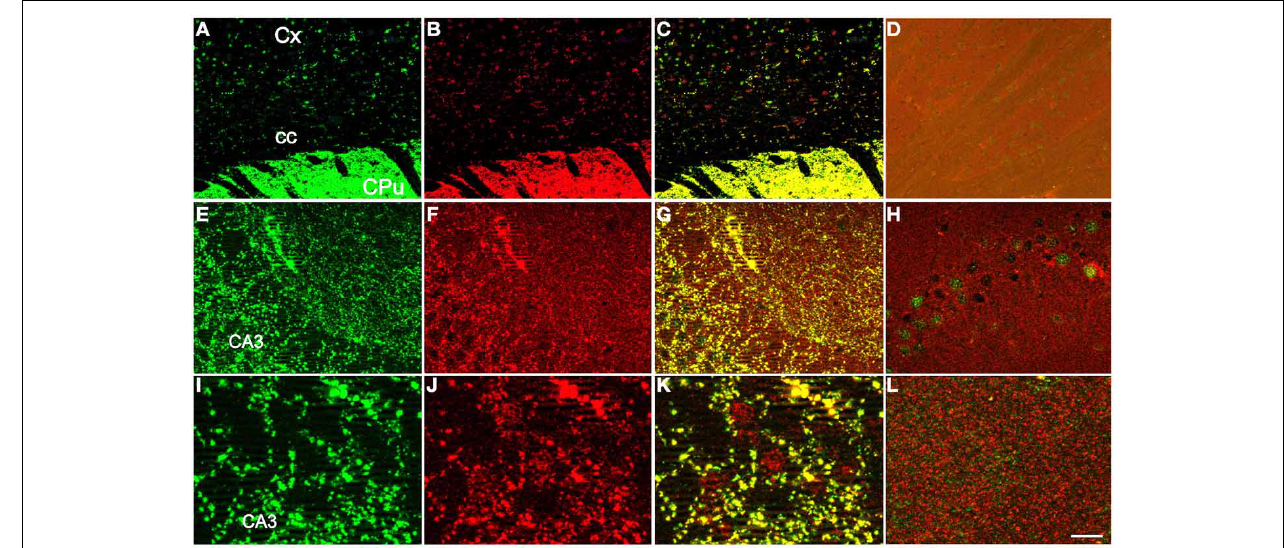
FIGURE 1 | Specificity of the newly developed anti-human VGLUT3 antiserum. The distribution of VGLUT3-positive immunolabeling was compared between the purified serum newly produced in rabbit against a human peptide (A,E,I) and a previously validated rodent anti-VGLUT3 in guinea pig (B,F,J) , (Gras et al., 2008; Amilhon et al., 2010; Miot et al., 2012). Immunofluorescence experiments were conducted as previously described (Gras et al., 2008; Amilhon et al., 2010; Miot et al., 2012) on sections taken at the level of the striatum (A–D) or hippocampus (E–L) of wild-type